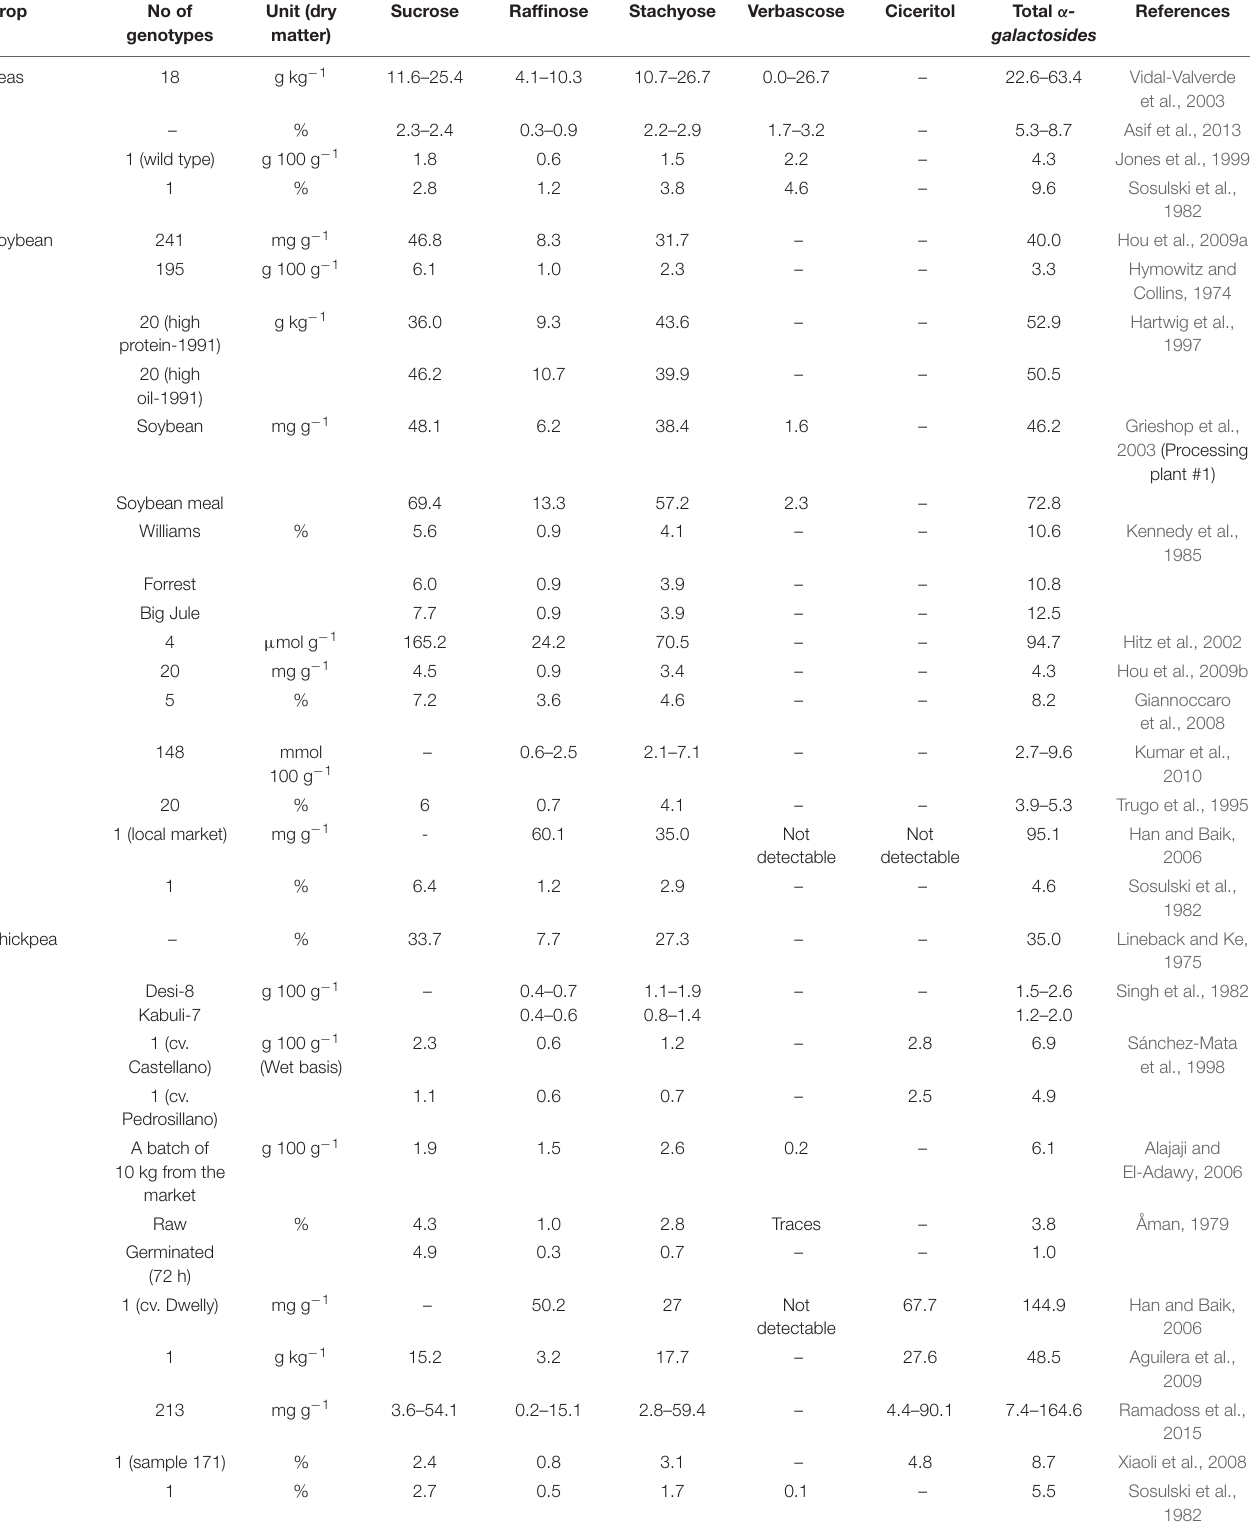
TABLE 1 | Variability of oligosaccharides present in the various grain legumes. Crop No of Unit (dry Sucrose Raffinose Stachyose genotypes matter)